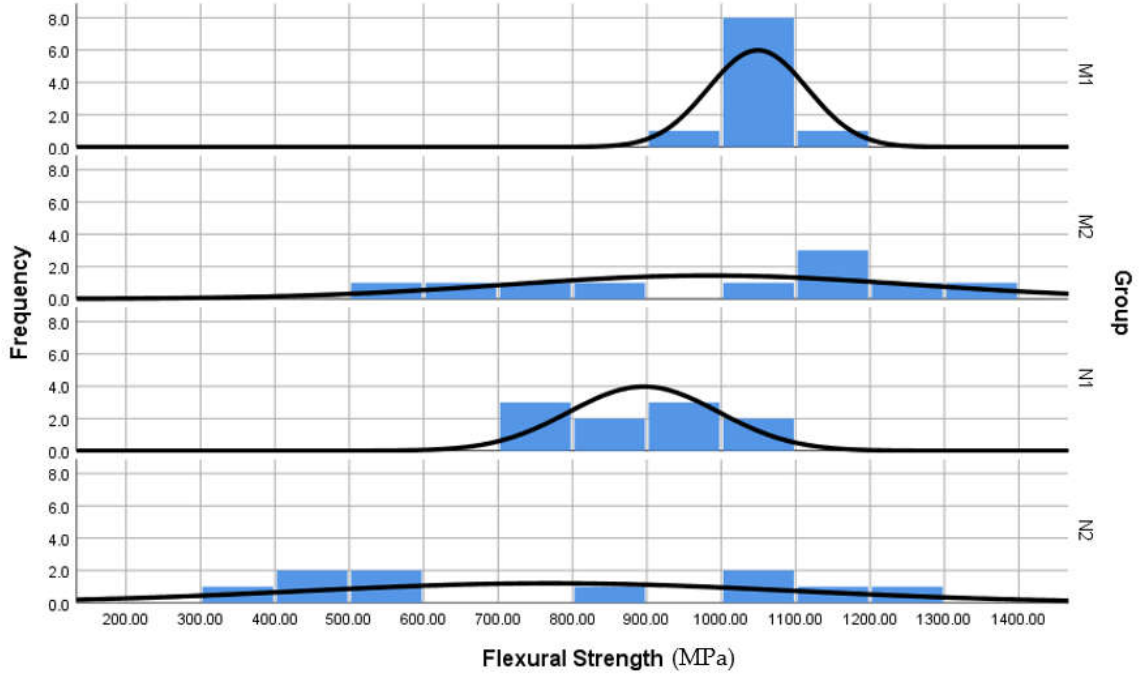
Figure 4. Frequency histogram polygon graph of the flexural strength stacked by group, comparing the pattern of values distribution between different groups.